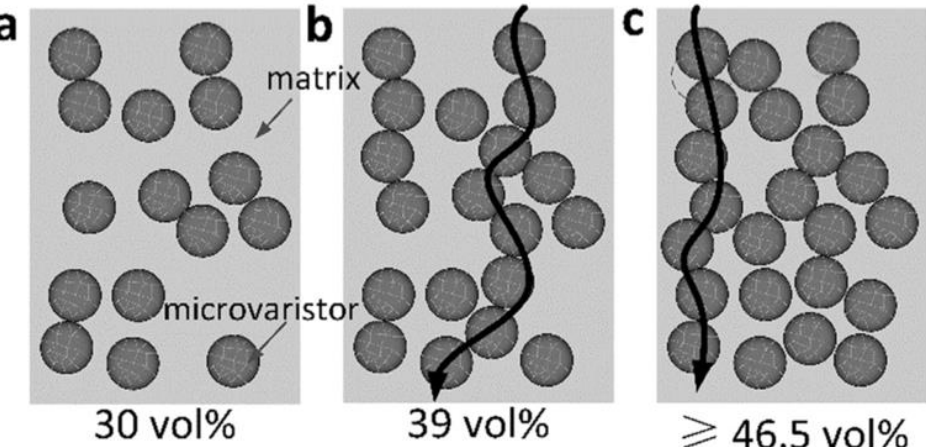
Figure 10. Schematic of filler distribution in ZnO/Silicone rubber composites with ( a ) 30 vol.%, ( b ) 39 vol.%, ( c ) ≥ 46.5 vol.% ZnO. Reprinted from Ref. [55], Copyright 2016, with permission from Elsevier.